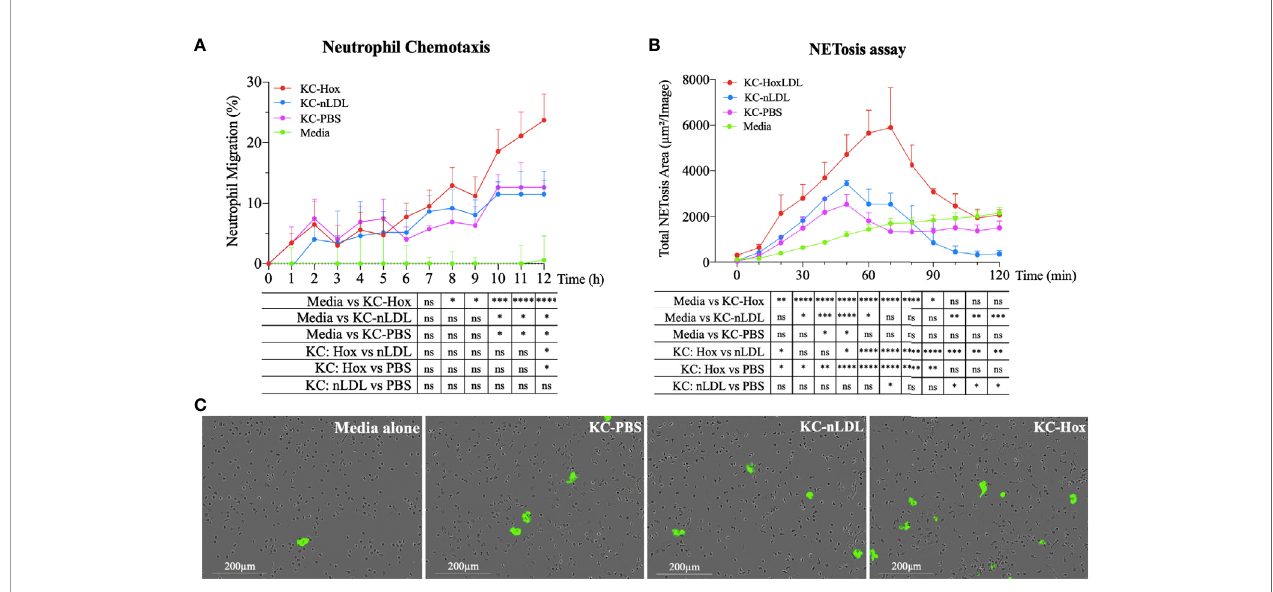
FIGURE 5 | HoxLDL-derived M4 polarization enhances neutrophil recruitment and NETosis. (A) The live-cell imaging assay showed increased neutrophil recruitment after 8 hours in culture with HoxLDL-stimulated macrophages conditioned media (KC-Hox). Even though the conditioned media from nLDL-stimulated KCs (KC- nLDL) or unstimulated KCs (KC-PBS) alone also recruited neutrophils, HoxLDL has the strongest effect on neutrophils ’ chemotaxis, achieving a migration peak at 12 hours (n = 5) . Two-way ANOVA test was used to detect statistical signi fi cance among time points, *p <0.05, **p <0.01, ***p <0.001, ****p <0.0001, ns, not signi fi cant. (B) KC-Hox conditioned media triggers NET formation, starting at 20 minutes and achieving a peak at 1h 10 minutes. KC-Hox ’ s NET induction was stronger than in conditioned media KC-PBS or KC-nLDL, lasting for almost 2 hours (n=3) . Two-way ANOVA test was used to detect statistical signi fi cance among time points, *p <0.05, **p <0.01, ***p <0.001, ****p <0.0001, ns, not signi fi cant. (C) representative images from NET induction assay. Cytotox green reagent ® was used to label expelled DNA: Unstimulated neutrophils (media alone), neutrophils incubated with KC-PBC, KC-nLDL, and KC-Hox at 1h 10min of the assay. Scale bar